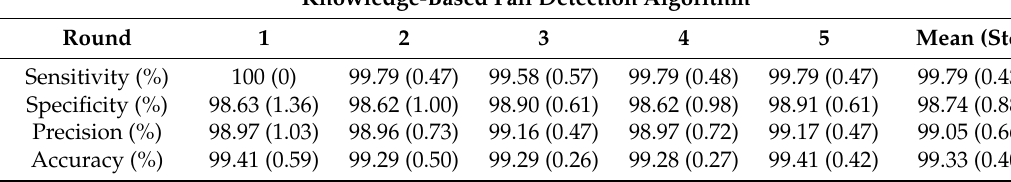
Table 4. The overall performance of five-fold cross-validation over five rounds for the knowledge-based fall detection algorithm. Std: standard deviation.